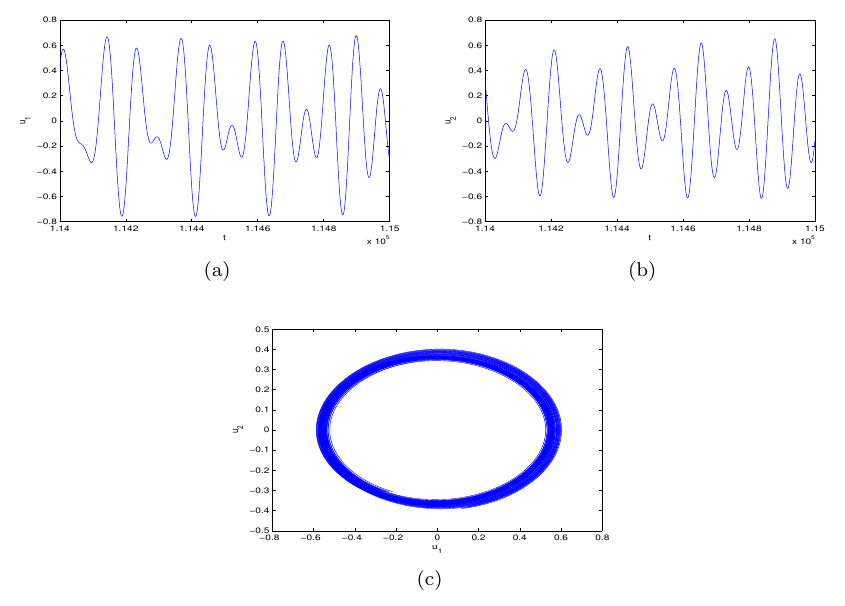
Figure 6. Simulated solution of system (4.1) for ( α 1 ,α 2 ) = ( − 0 . 001 . 0 . 021): showing a stable quasi-periodic